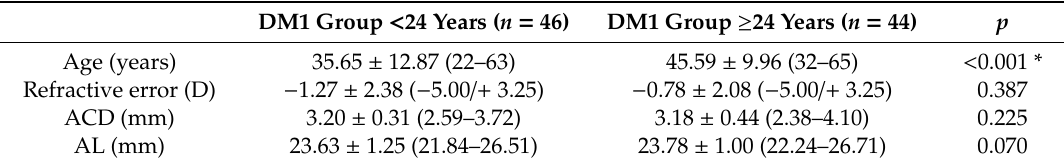
Table 3. Demographics and ocular characteristics of the type 1 diabetes Mellitus (DM1) Group divided depending on the time DM1 evolution: Group 1, less than 24 years and Group 2, more than or equal to 24 years. Values are presented as the mean ± standard deviation and range (minimum–maximum). Significant di ff erences were considered as p < 0.05, calculated by Kolmogorov–Smirnov test for two independent nonparametric samples, are shown with *.